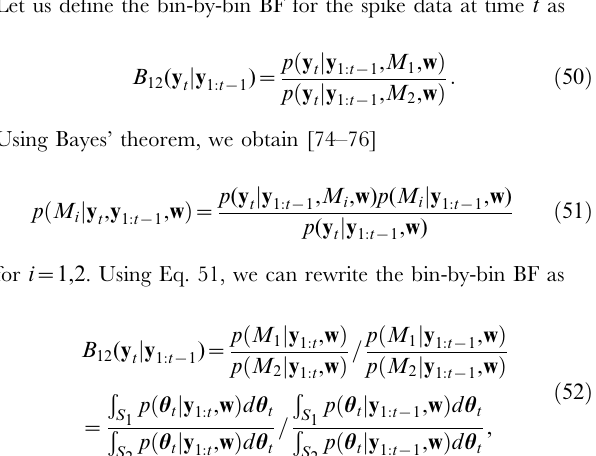
Figure 8A). These are: (I) an independent model ( h t